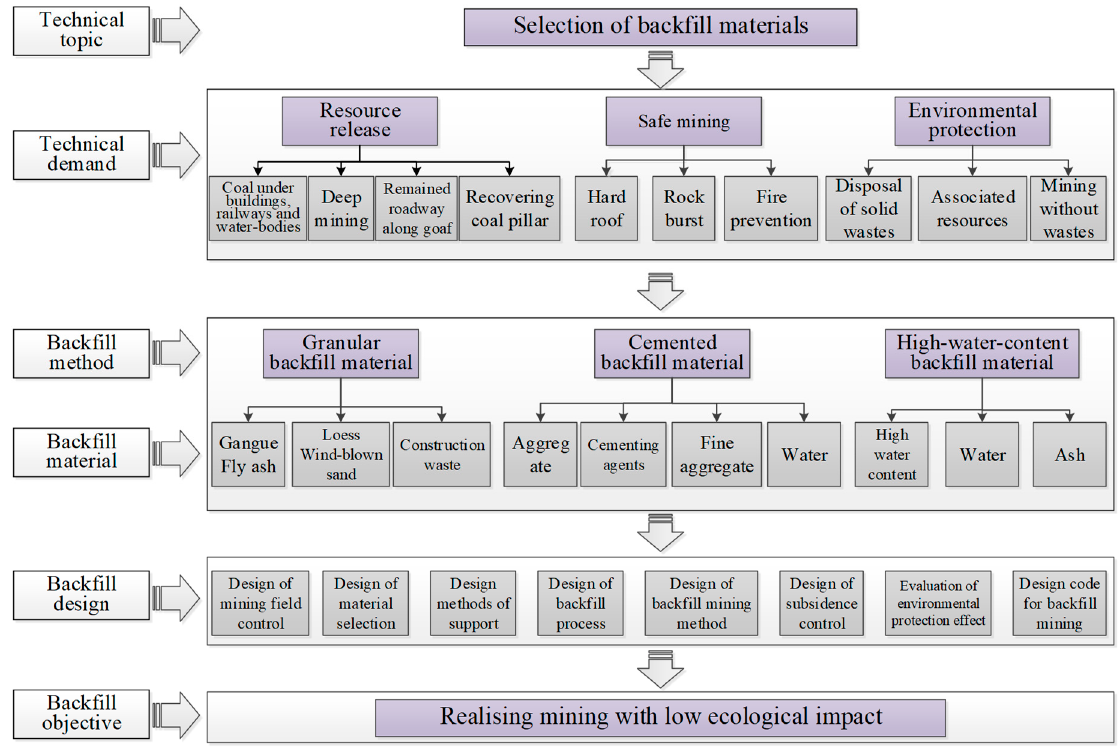
Figure 13. Engineering demands for selecting backfill mining materials.